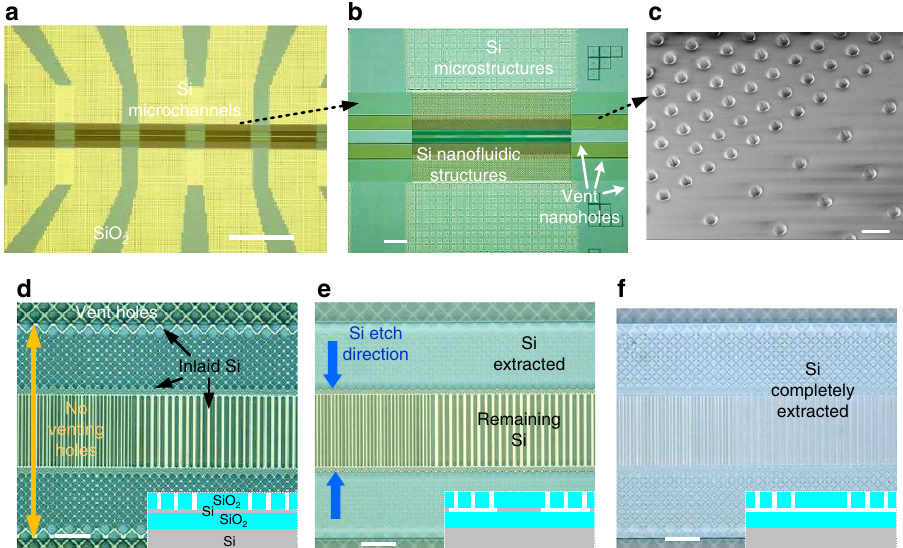
Figure 3 | Sacrificial Si etching by XeF 2 . ( a , b ) Optical images of fabricated sacrificial nanofluidic device prior to Si extraction, showing: ( a ) multiple fluidic branches on one chip; ( b ) Si microchannels connected by DUV-/EBL-fabricated Si structures in the middle. ( c ) 30 (cid:2) tilted SEM image of venting nanoholes in SiO 2 , with 300nm diameters and different pitches (1 m m and 2 m m). ( d – f ) Optical images showing different stages of XeF 2 etching: ( d ) before etching; ( e ) after partial Si extraction; ( f ) after complete Si extraction. The scale bars are 1mm, 100 m m, 1 m m in figures ( a – c ), respectively, and 10 m m in d – f